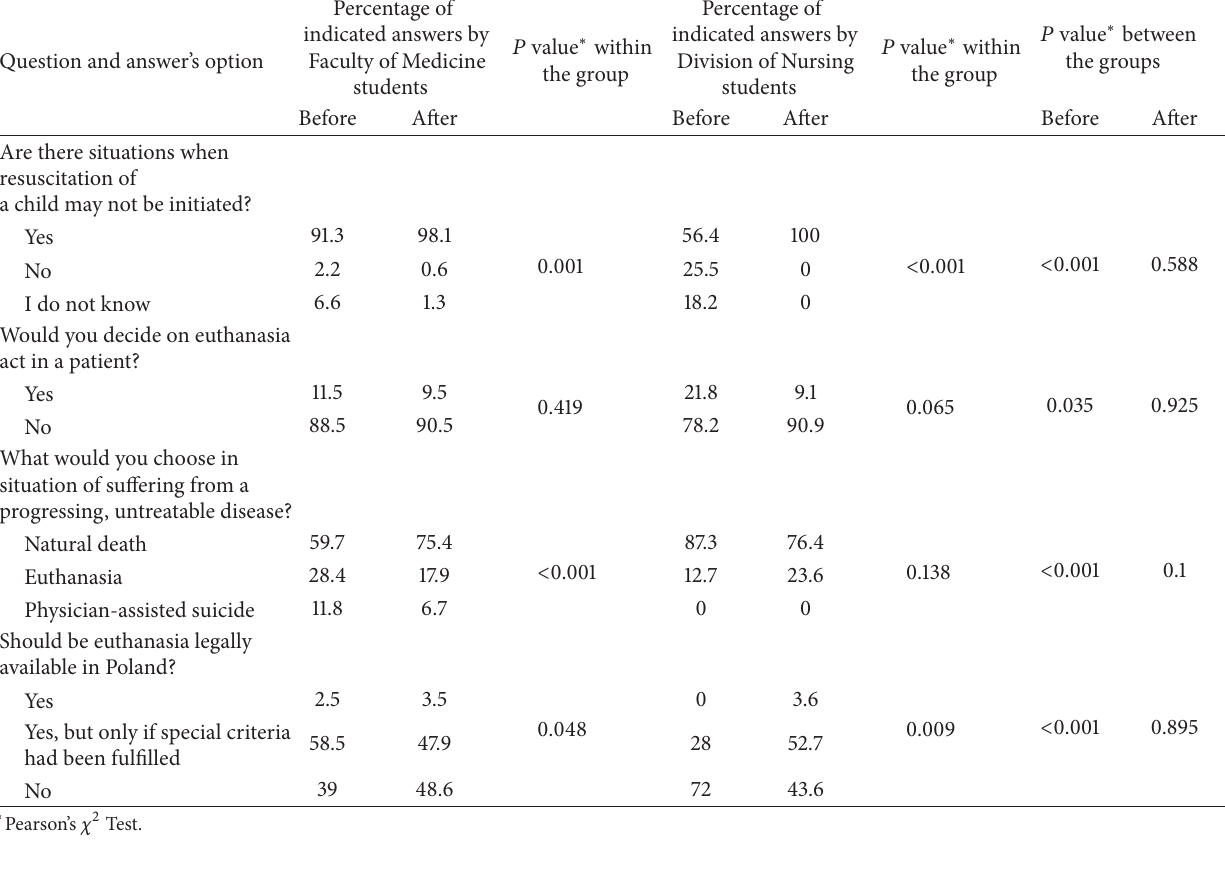
Table 2: Students’ opinion on specific problems of palliative care before and after education programme.